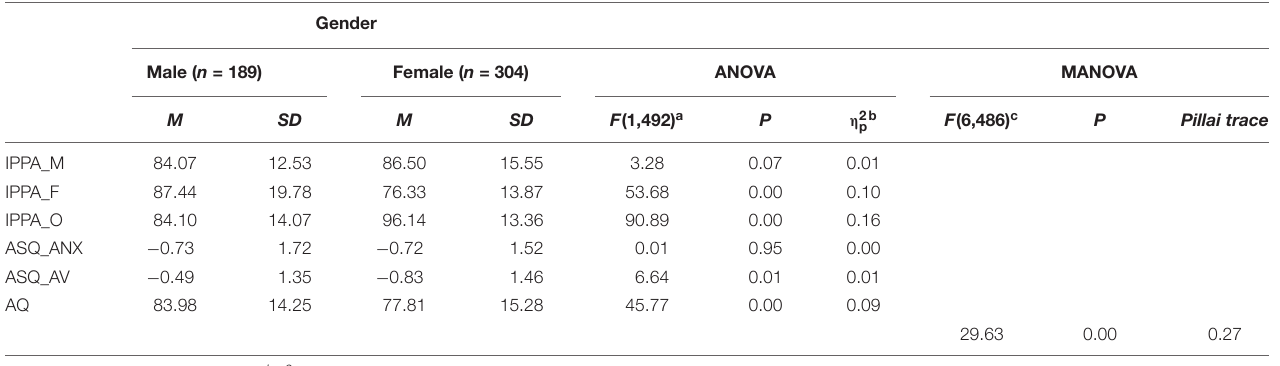
TABLE 1 | Means and Standard Deviations for mother, father and close friends attachment (IPPA), anxiety and avoidance dimensions of attachment style questionnaire (ASQ) and aggression questionnaire (AQ) according to gender ( N = 493). Gender ANOVA MANOVA